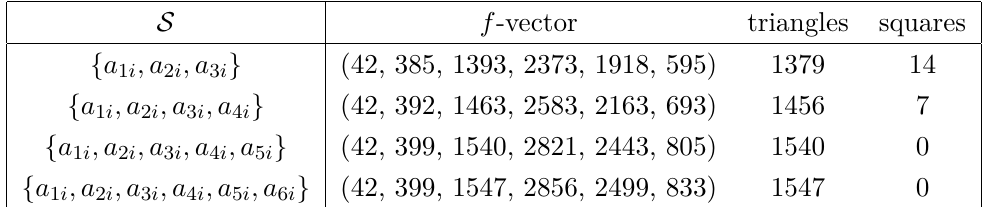
Table 2. Different possible fans for Gr(3 , 7) with their f -vectors as well as a characterisation of the dimension two